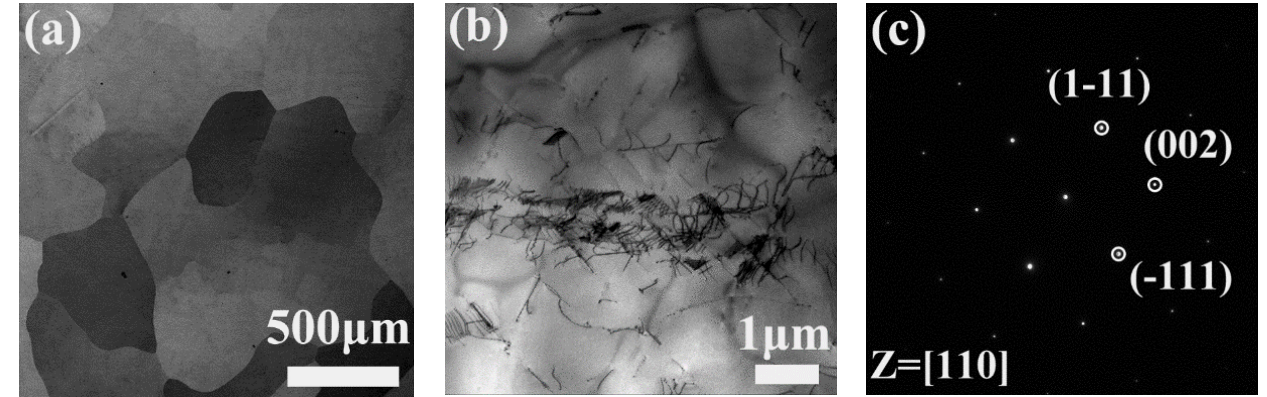
Figure 1. SEM and TEM images of as-castAl 0.3 CoCrFeNi high-entropy alloy: ( a ) BSE image; ( b ) BF image; ( c ) SADP image.